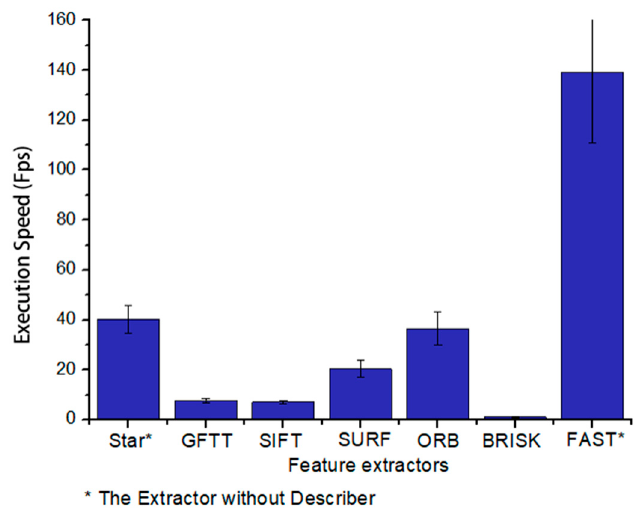
Figure 2. Execution speed comparison of some popular feature extractors (input image size: 640 × 480, feature points < 1000).